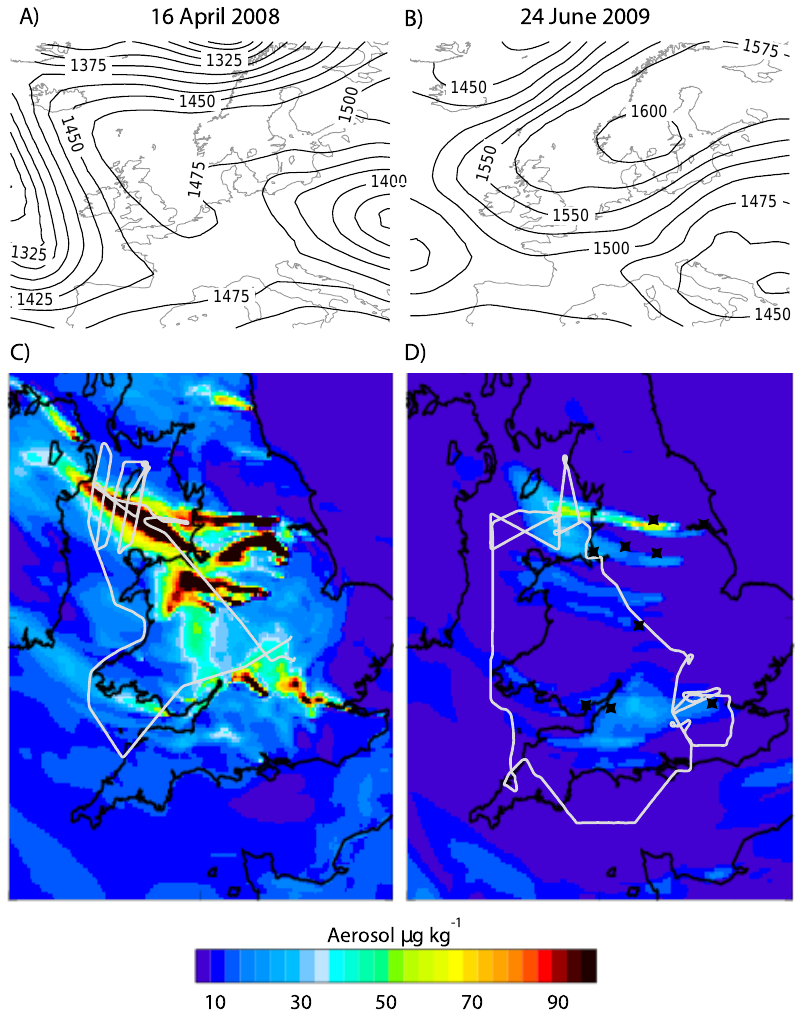
Fig. 1. Geopotential height fields at the 850hPa pressure level from the ECMWF ERA interim reanalysis at 12:00UTC for the 16 April 2008 (a) and 24 June 2009 (b) . Panels (c and d) show the aircraft flight tracks in white overlaying the UK4 visibility model-predicted aerosol mass fields at the approximate level of the aircraft (approximately 200ma.s.l. on 16 April and 680ma.s.l. on 24 June) for periods when the aircraft was flying in the northwestern plumes. The locations of major UK cities are shown by black crosses in panel (d) . See Fig. 2 for labels.